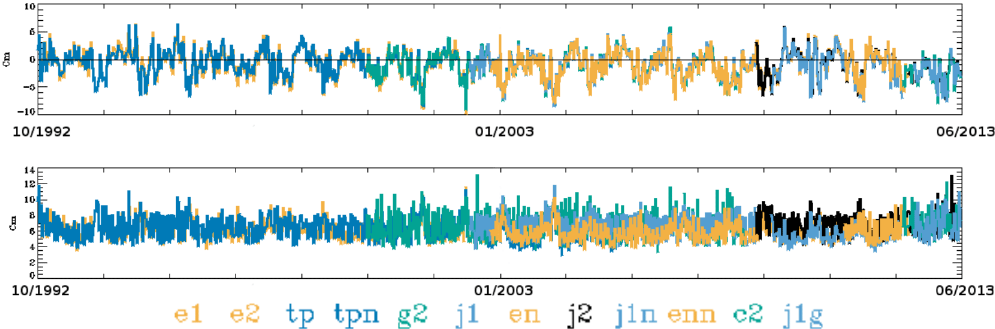
Figure 3. Time series of weekly sea level anomaly (SLA; m) data assimilation statistics averaged over the whole Mediterranean basin: mean innovation (top) and rms of innovation (bottom). The colors stand for different satellites (please refer to Table 3).